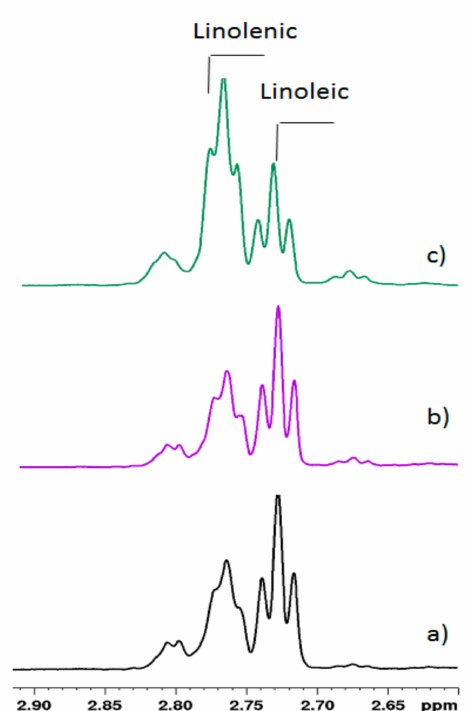
Figure 4. Bis -allylic methylene region of 600 MHz 1 H NMR spectra of goat milk lipid fraction from ( a ) control, ( b ) hempseed, and ( c ) linseed diets in CDCl 3 at 298 K. Changes in the signal ratios of linoleic acid and linolenic acid depending on the diets are clearly visible.